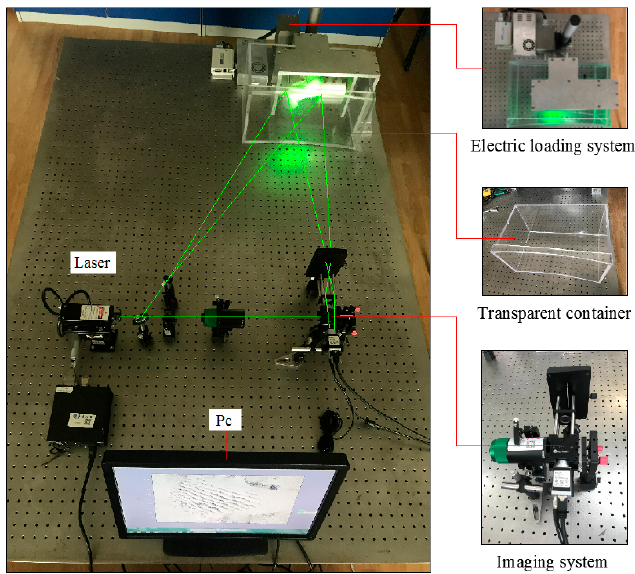
Figure 3. Experimental set-up for strain detection.